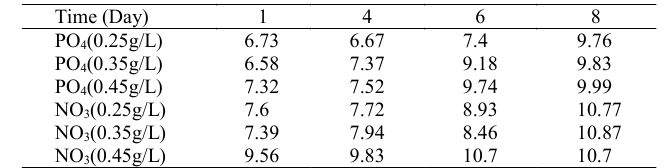
Table 3: pH changes in the culture of Spirulina platensis at various time intervals